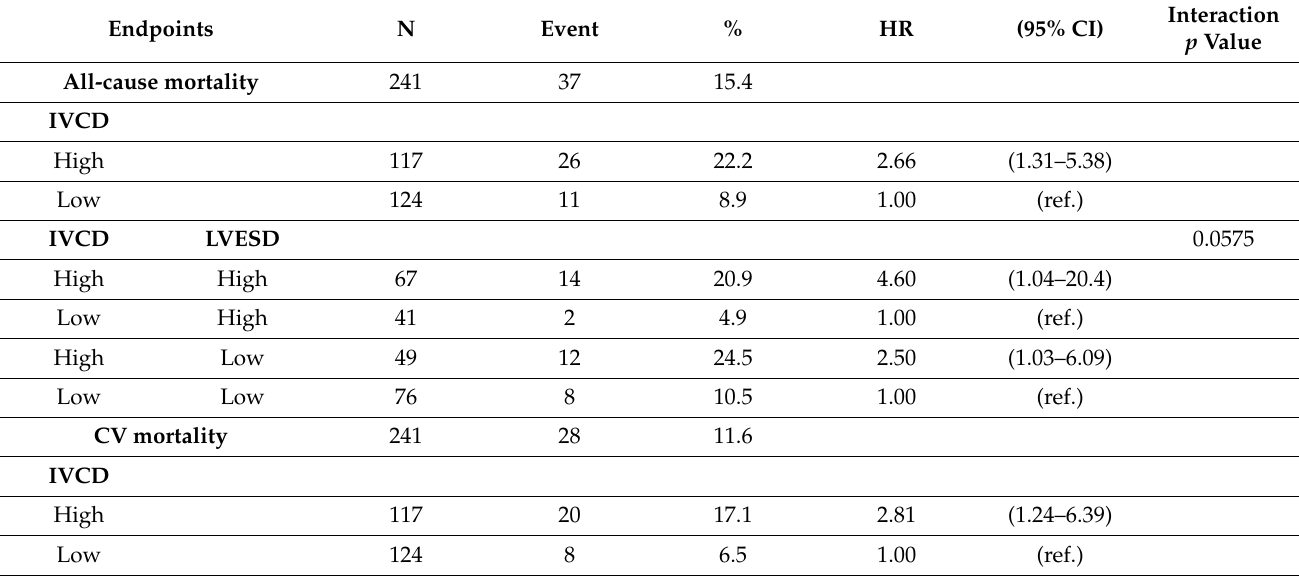
Table 5. Subgroup Cox regression analysis for IVCD between high- and low-LVESD with all-cause mortality, CV mortality, and